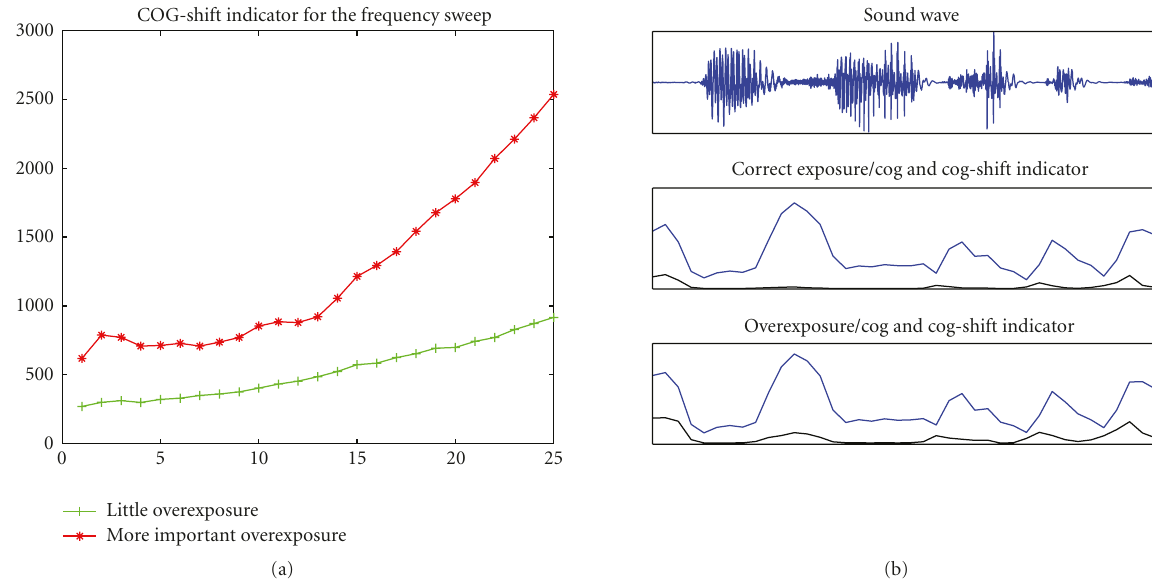
Figure 19: (a): COG-shift plotted over time for the frequency-sweep input. As expected, our indicator rises as frequency increase. (b): COG plot (blue) and COG-shift indicator (black) for a real-sound sample. Even if the variation is small, it is e ff ective over the complete sample.